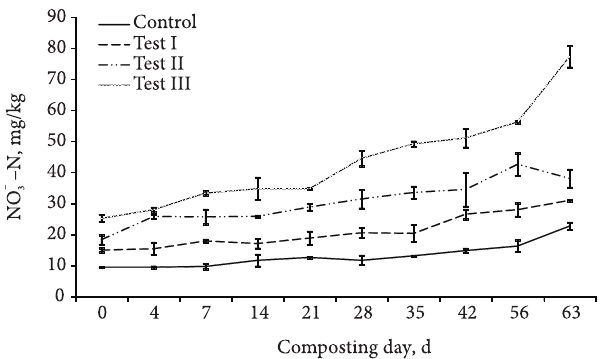
Fig. 7. The NO 3- -N profile during